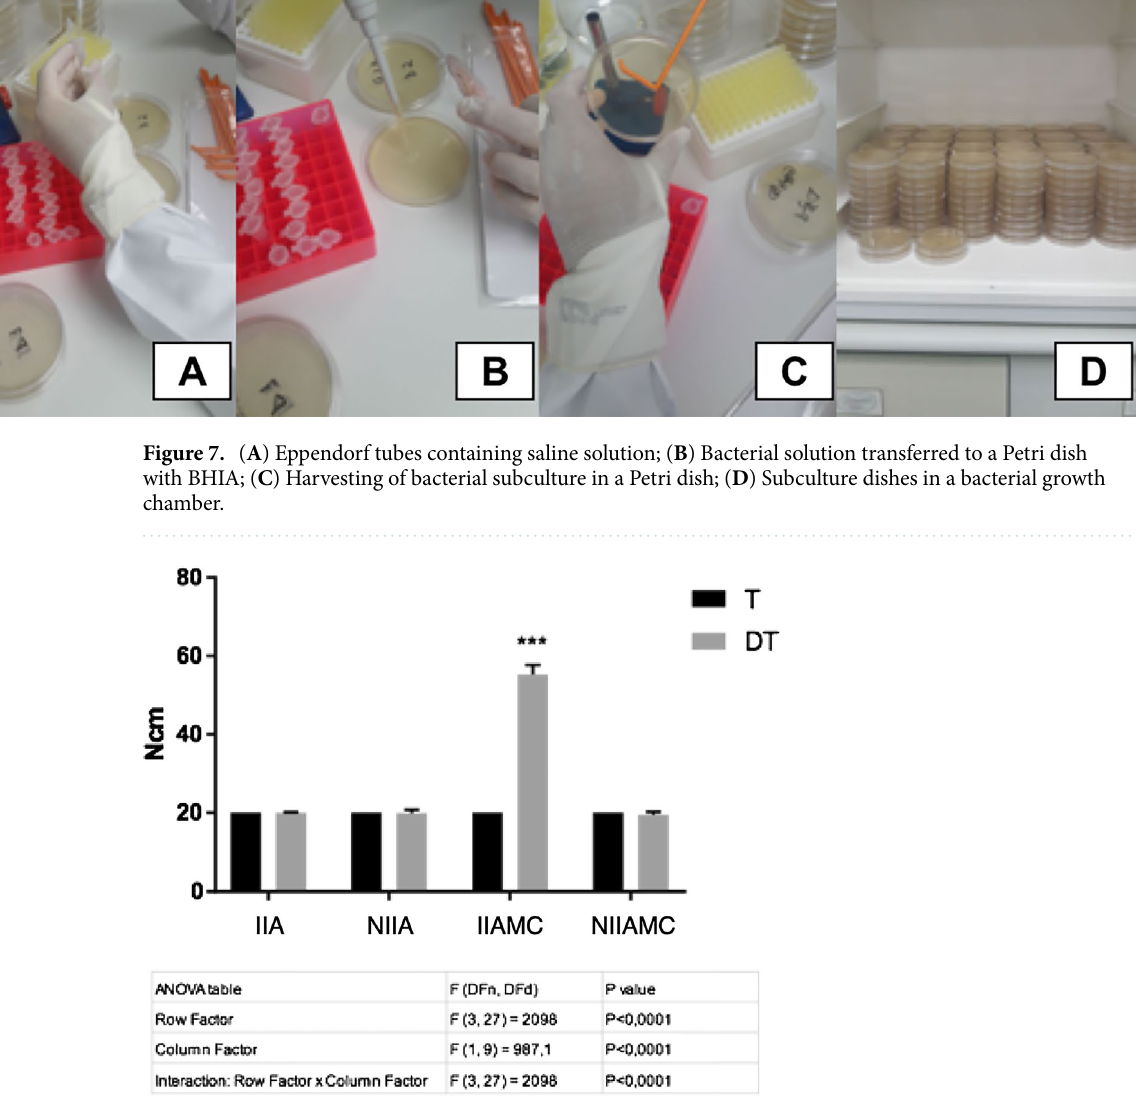
Figure 8. Statistical analysis of the detorque values of the specimens—Two-Way Repeated Measures ANOVA, followed by Tukey’s